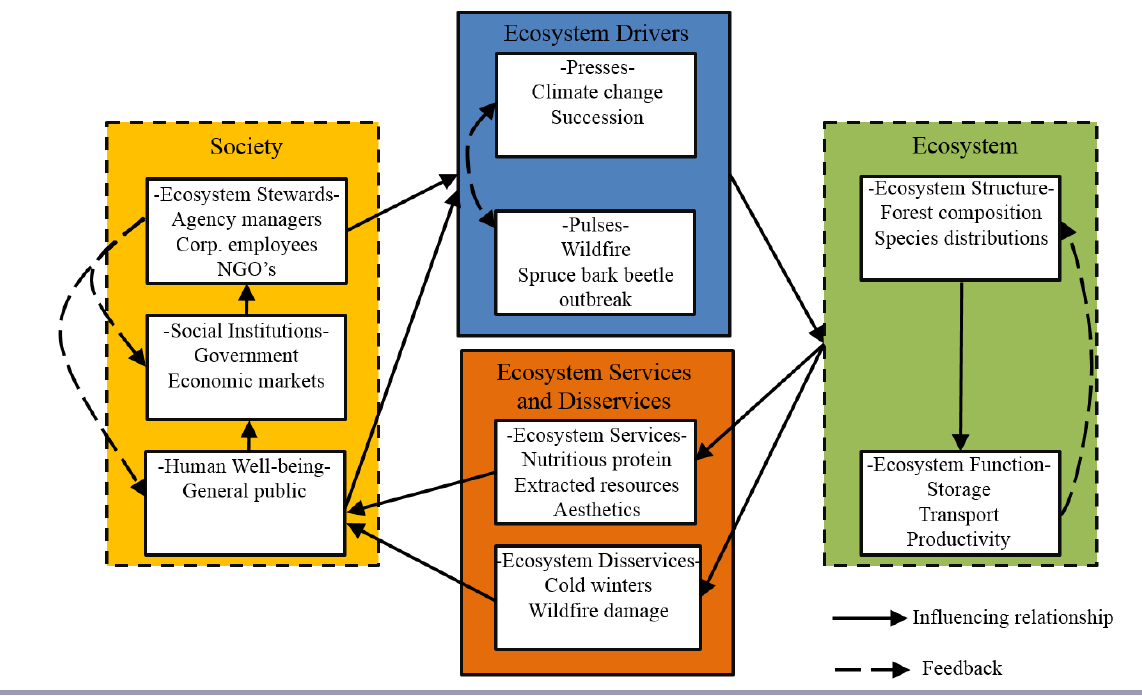
Fig. 1 . Press-pulse dynamics conceptual framework (Collins et al. 2011), adapted to reflect context and scales of Alaskan case studies. In the framework, press- and pulse-ecosystem drivers shape ecosystem structure and function, which determine the quality and quantity of ecosystem services and disservices provisioned. Tradeoffs between services and disservices shape human wellbeing, which dictates environmental policy and natural resource management